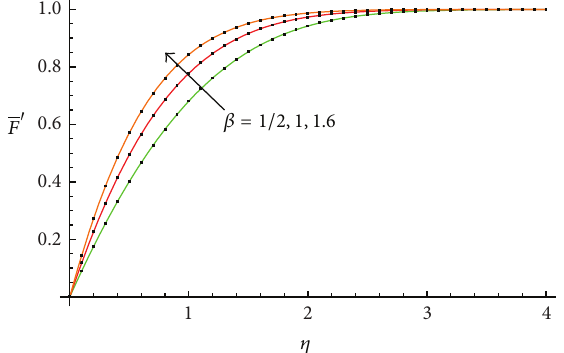
Figure 8: Comparison between the velocity profile obtained from (55), (63), and (71) and numerical results for 𝛽 = 1/2 , 1, and 1.6, respectively: —numerical; ... OHAM